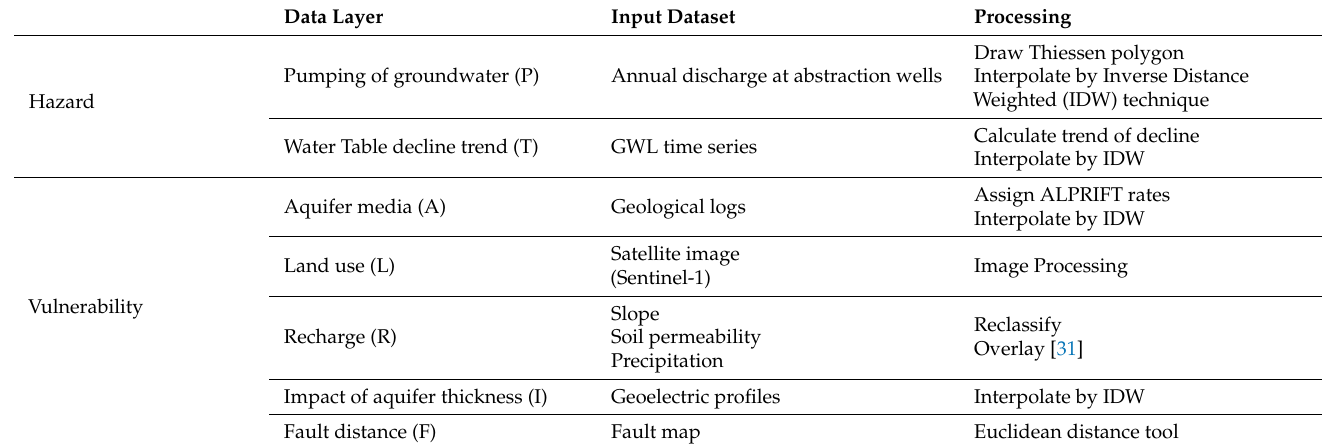
Table 2. Required input datasets and GIS-processing for ALPRIFT data